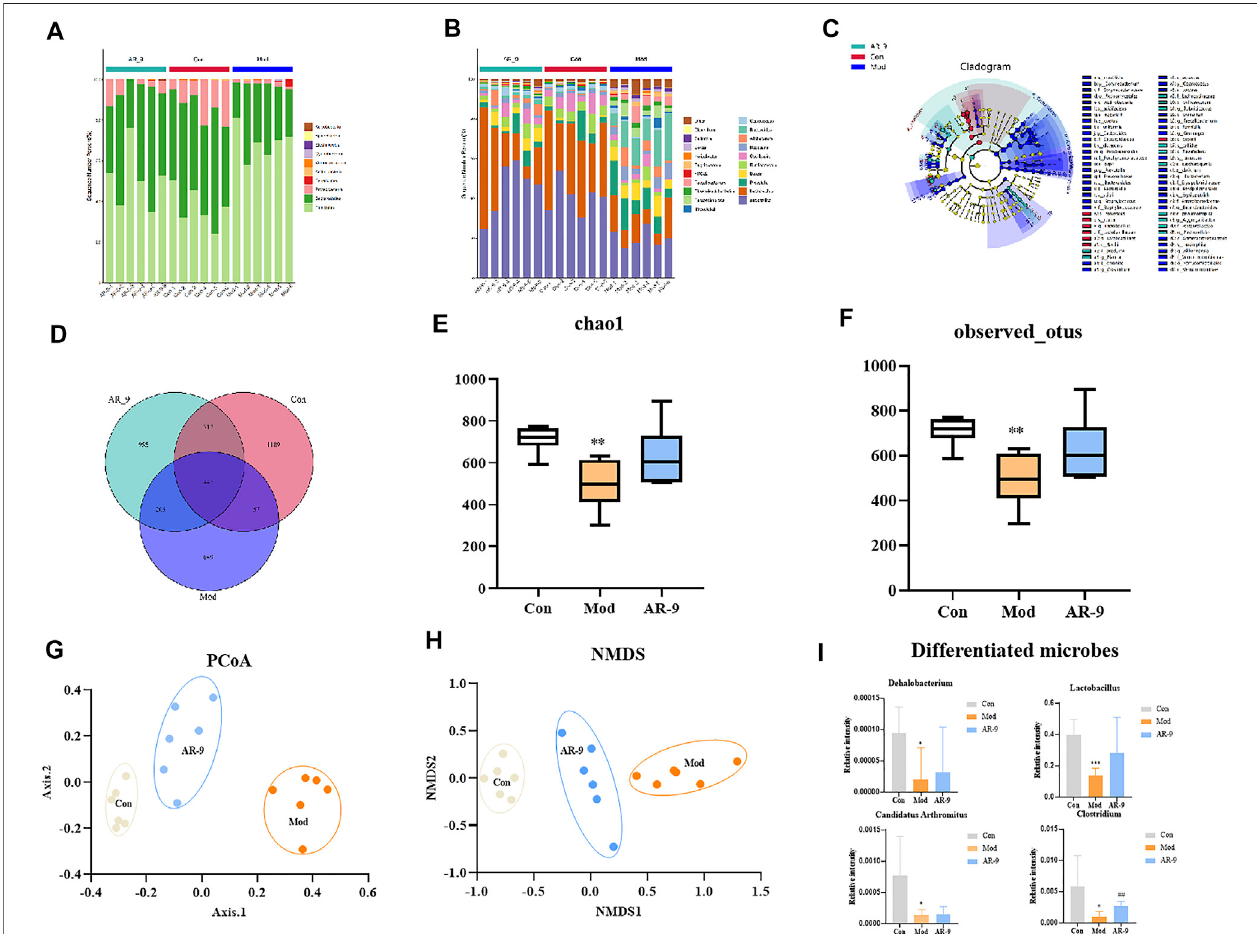
FIGURE 5 | Intestinal microbiota analysis results of AR-9 treatment of HL. The histogram of species distribution at the phylum (A) and genus (B) levels in three groups was revealed by 16S rRNA sequencing (different colors represent different bacteria at phylum or genus levels). (C) Taxonomic cladogram generated by LEfSe analysis showing the differences of bacterial abundance on the genus level. (D) Venn diagram for bacterial communities of Con, Mod, and AR-9 groups. (E) Chao1 and (F) observed OTUs represent alpha-diversity indexes for each sample group. (G) PCoA analysis among Con, Mod, and AR-9 groups. (H) NMDS analysis among Con, Mod and AR-9 groups. (I) Results of four differential dominant bacteria at the genus level among AR-9 groups. * p < 0.05, ** p < 0.01 and # p < 0.05, and ## p < 0.01 vs. Con or Mod group.